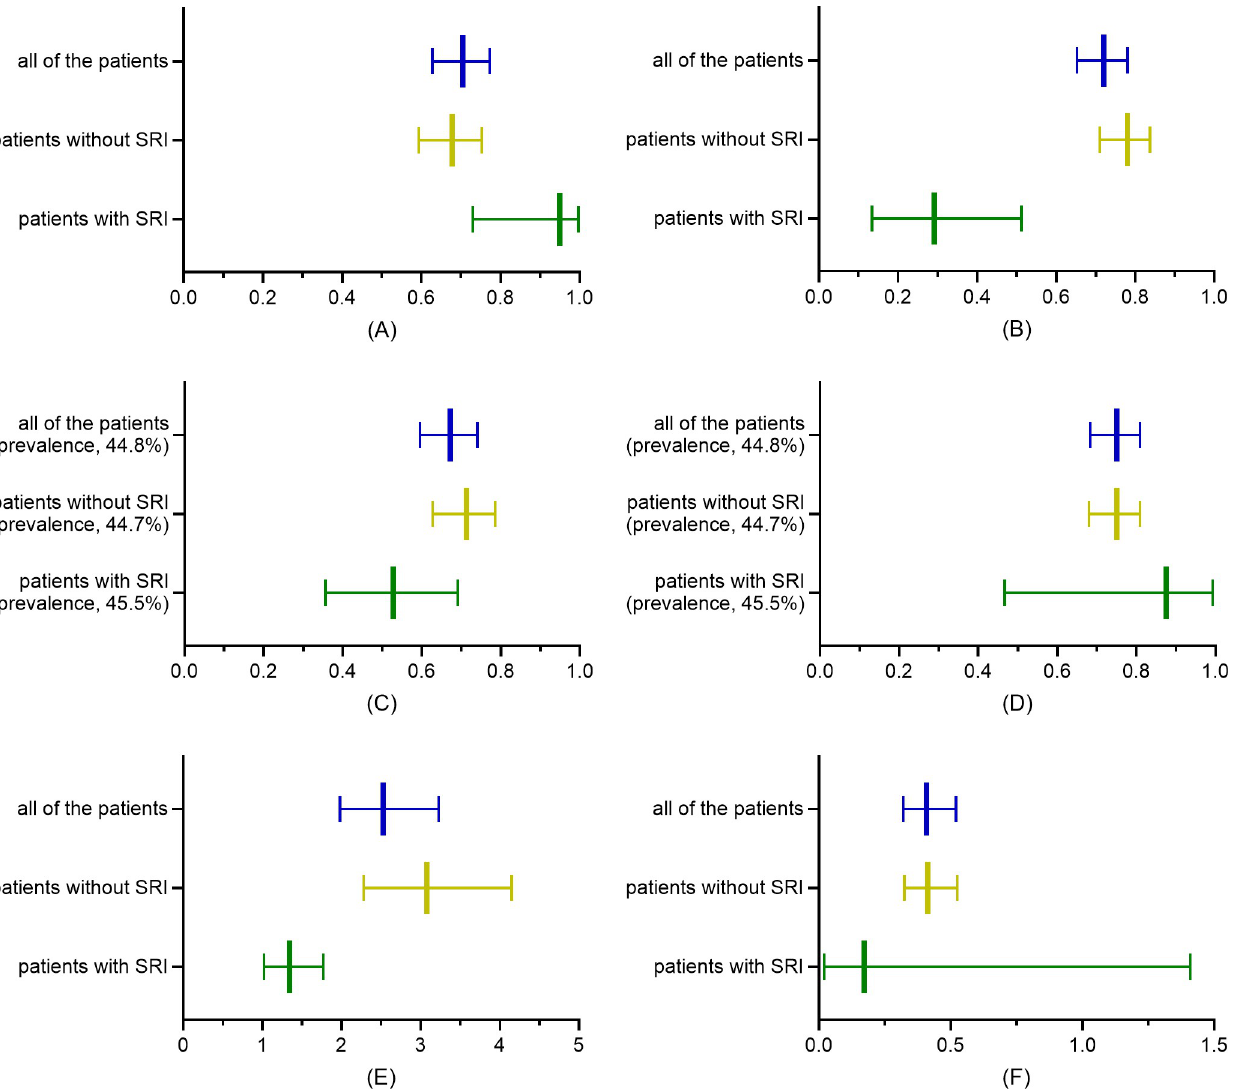
Fig 4. Box–Whisker plot of sensitivity, specificity, PPV, NPV, LR+, and LR–for all of the patients and the two subgroups. The panels summary the sensitivity (A), specificity (B), PPV (C), NPV (D), LR+ (E), and LR–(F) with their 95% CIs at optimal cutoff points for all of the patients (45 mm/h), patients without SRI (45 mm/h), and patients with SRI (42 mm/h), which were calculated by VassarStats. It is apparent that the sensitivity, specificity, PPV, NPV, LR +, and LR–between all of the patients and patients without SRI are generally similar, with widely overlapping 95% CIs. What is interesting is that, the specificity, PPV, and LR+ in patients with SRI are strikingly lower than the other two groups and 95% CIs do not widely overlap with them. These implies a declining predictive value of DFO by ESR in patients with SRI. CI, confidence interval; DFO, diabetic foot osteomyelitis; ESR, erythrocyte sedimentation rate; LR+, positive likelihood ratio; LR − , negative likelihood ratio; NPV, negative predictive value; PPV, positive predictive value; SRI, severe renal